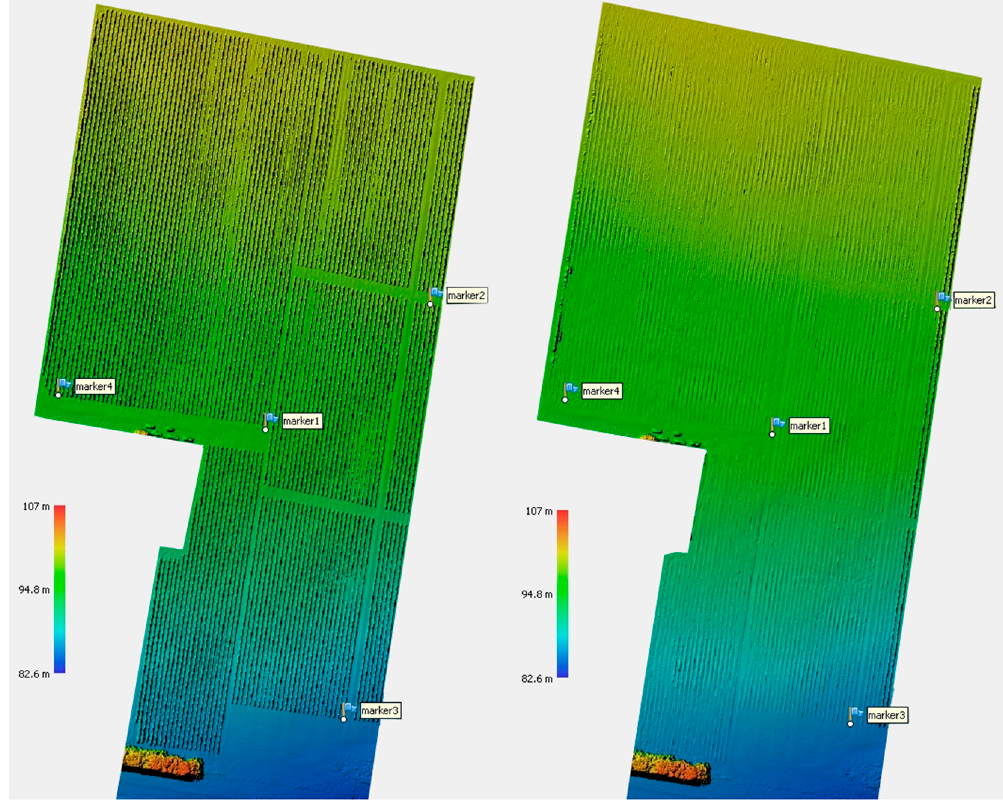
Figure 7. Result of the digital surface model (DSM) and digital terrain model (DTM) of Site 1. Markers are the ground control points (GCP).